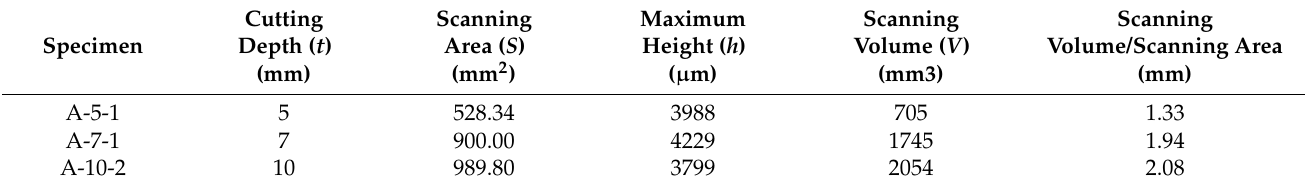
Table 2. Micro-characteristic parameters of the fractured section from